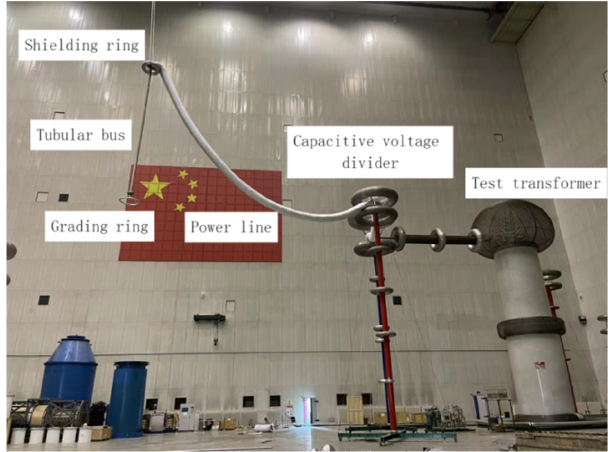
Figure 9. Layout of COI tests of grading rings.